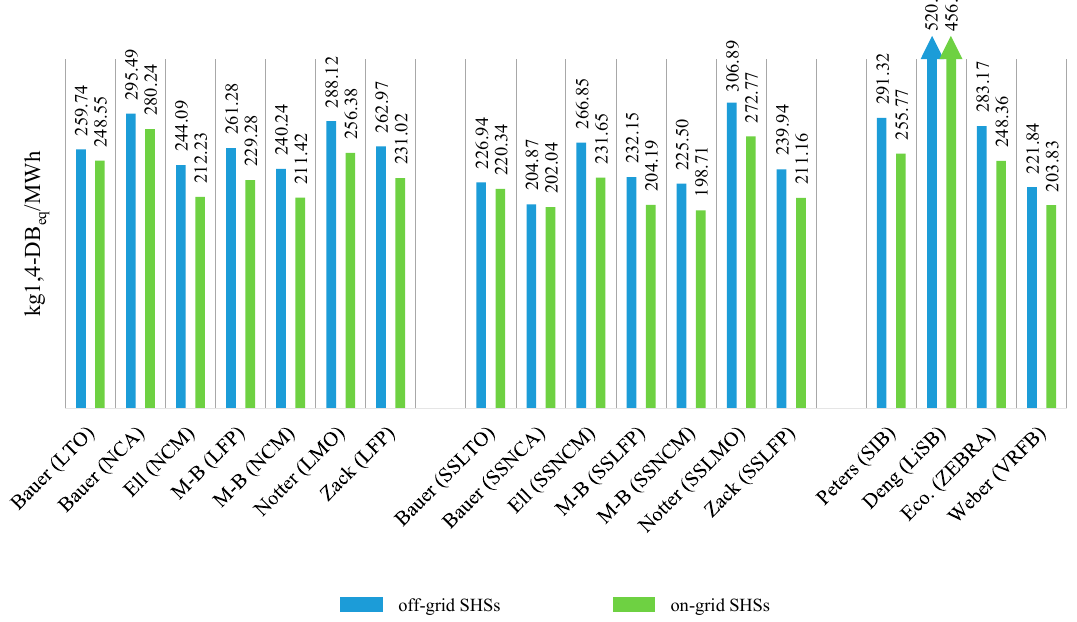
Figure 3. LCA impact values of SHSs in Italy for Human Toxicity indicator.